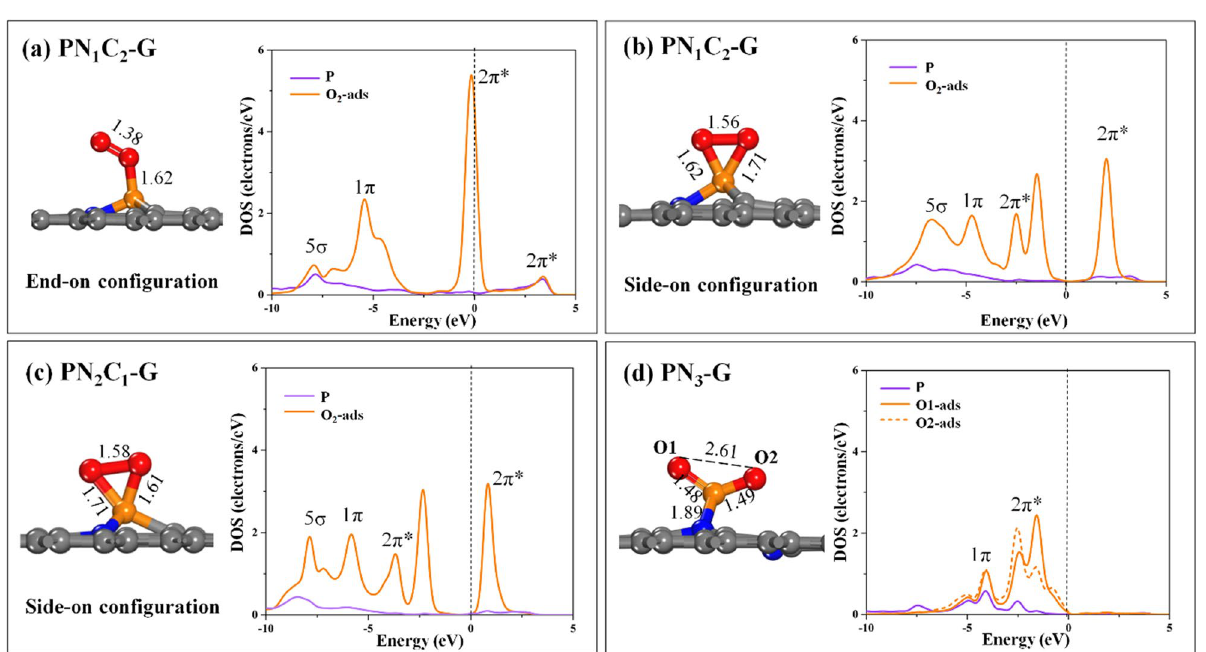
Figure 4. Optimized geometries and corresponding PDOS plots for the adsorption of O 2 on ( a ) PN 1 C 2 -G (End-on), ( b ) PN 1 C 2 -G -(Side-on), ( c ) PN 2 C 1 -G , and ( d ) PN 3 -G . All bond distances are in Å. In the PDOS plots, the dashed line indicates the Fermi level (E F ) level, which is set to